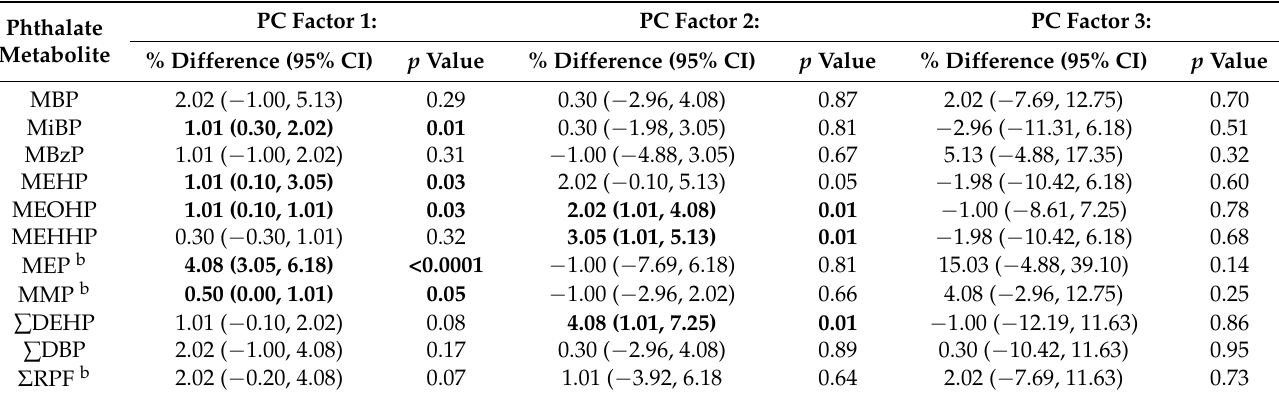
Table 5. Percent difference in specific gravity-adjusted urinary phthalate metabolites associated with principal components (PC) representing food and beverage consumption habits, among Black pregnant women (n =